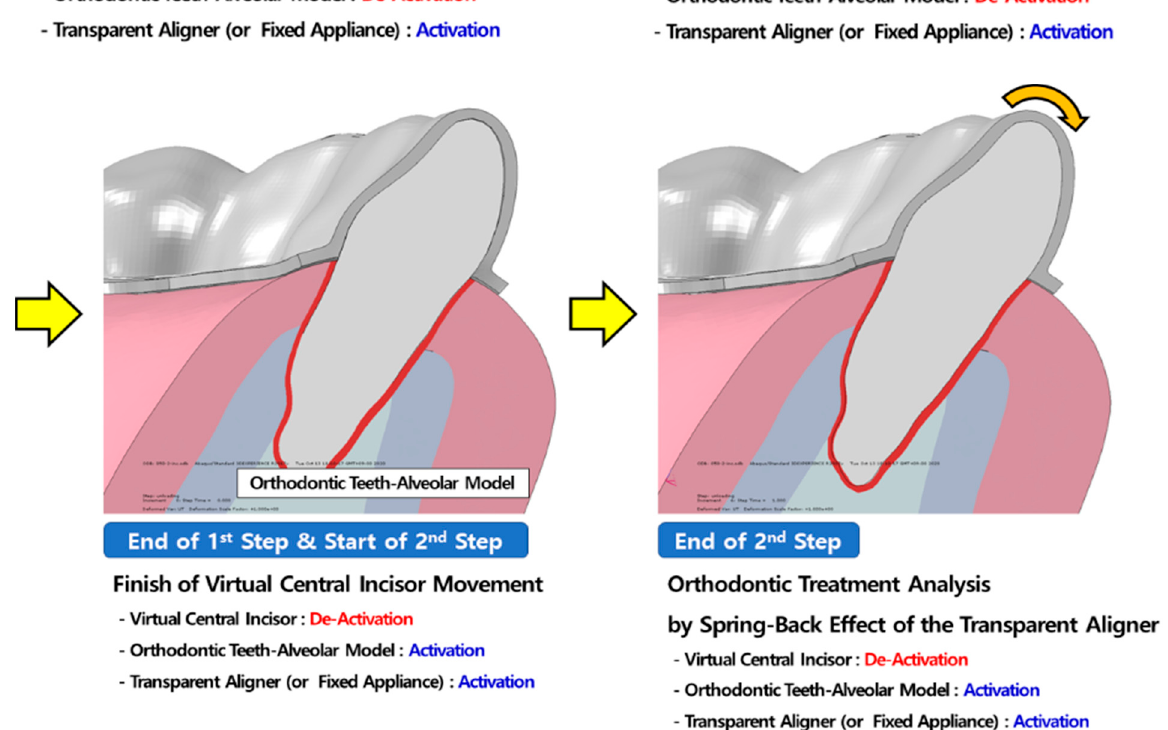
Figure 11. Process of orthodontic treatment analysis. The same method used for verification analysis was used, and the same loading conditions were applied to the analysis of the fixed appliance.